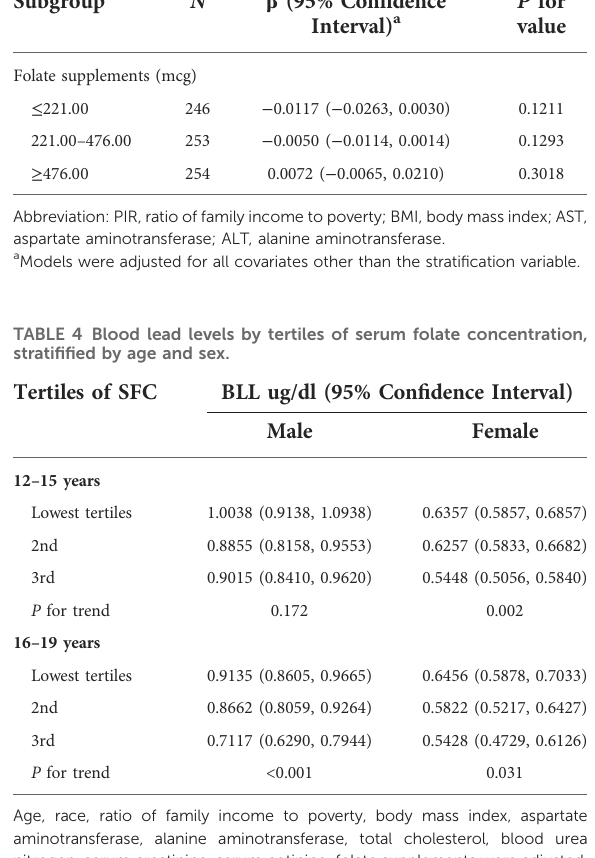
Age, race, ratio of family income to poverty, body mass index, aspartate aminotransferase, alanine aminotransferase, total cholesterol, blood urea nitrogen, serum creatinine, serum cotinine, folate supplements were